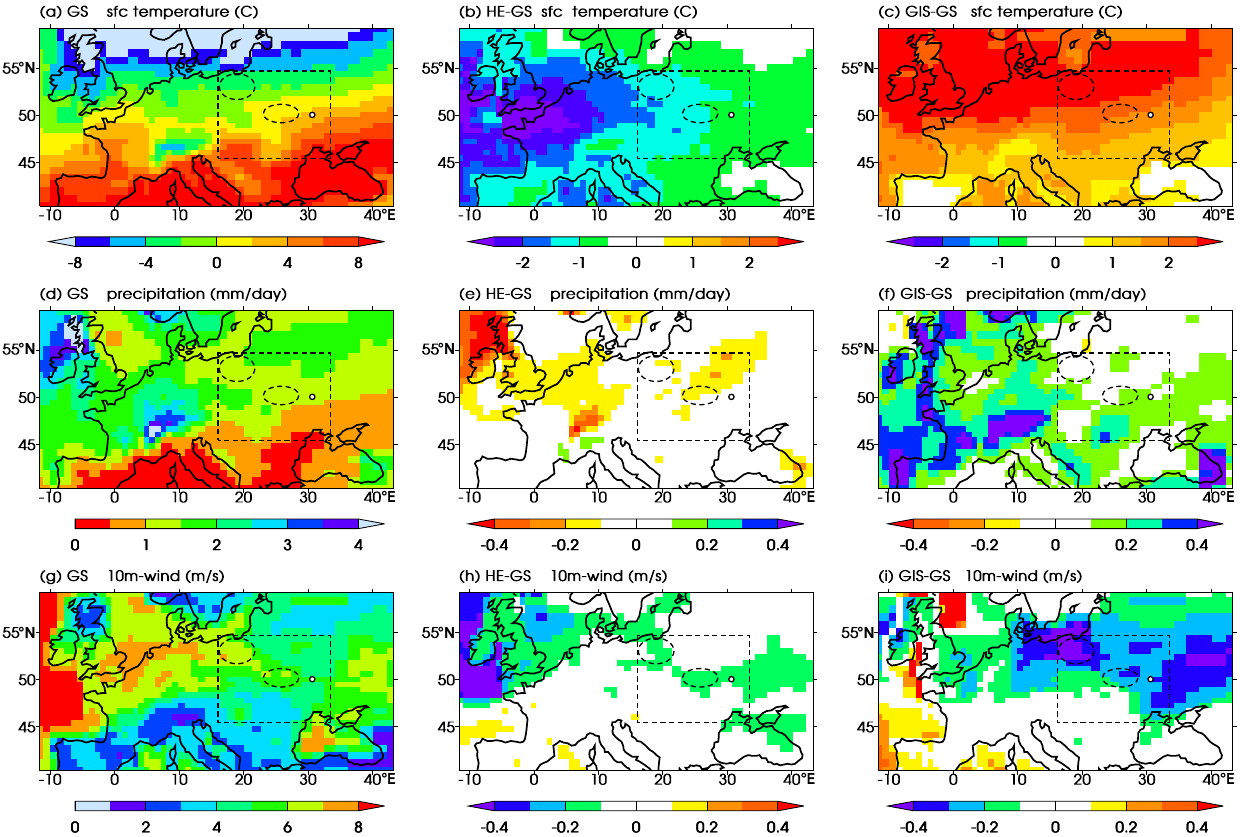
Fig. 7. February to June averages of 2m temperature (a–c) , precipitation (d–f) and 10m wind (g–i) for the GS state (left column), and anomalies HE-GS (center column) and GIS-GS (right column). In white are areas where the differences are not significant at the 95% confidence level (Student’s t test on a series of 20 data points, representing the averages of the February to June interval from the 20yr of run for each climate